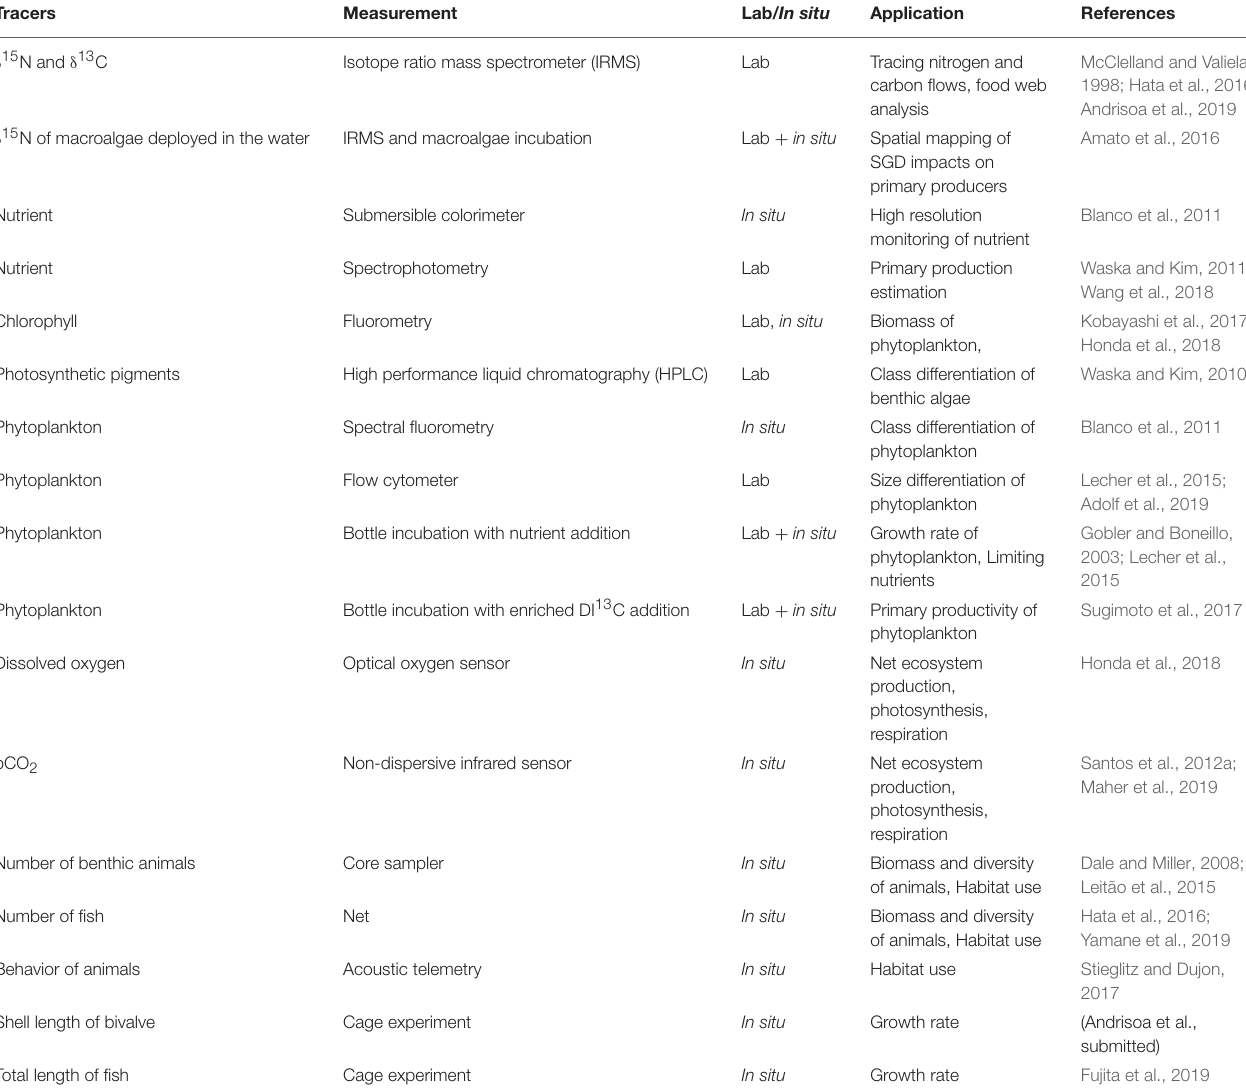
TABLE 2 | Summary of the main bio-ecological parameters used in SGD related